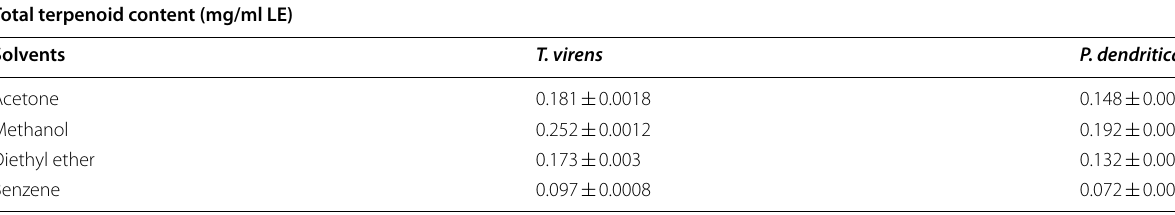
Table 6 Quantitative estimations of total terpenoid Total terpenoid content (mg/ml LE)